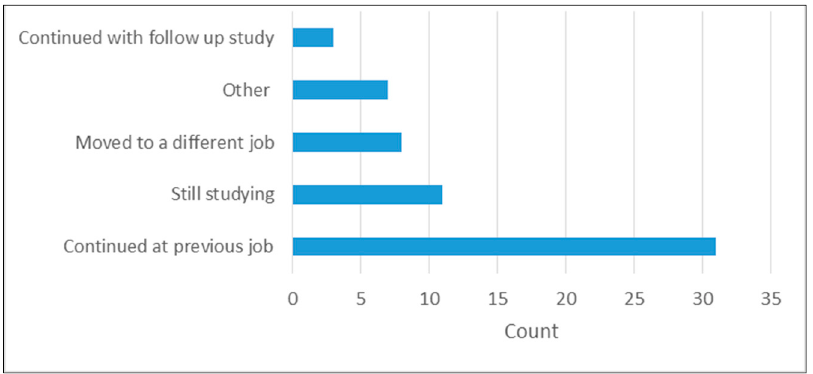
Figure 4. Occupation of APFNet Scholarship Program awardees after completing studies (number of students).